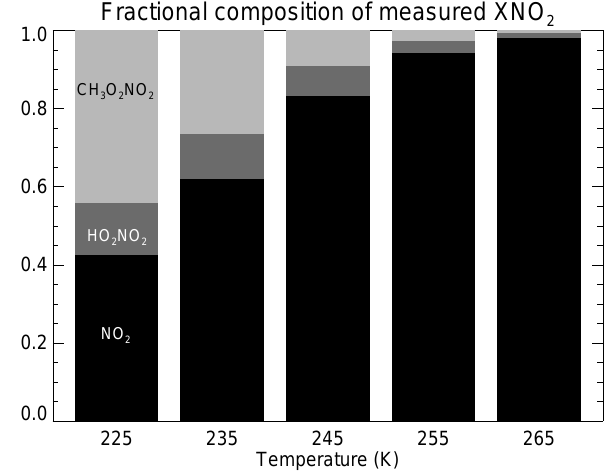
Fig. 2. Fractional composition of the XNO 2 measured by the UC Berkeley LIF nitrogen oxides instrument calculated using the pho- tostationary state model constrained to total measured XNO 2 . We estimate that 48–77% of CH 3 O 2 NO 2 and 3–6% of HO 2 NO 2 dis- sociate in the inlet prior to